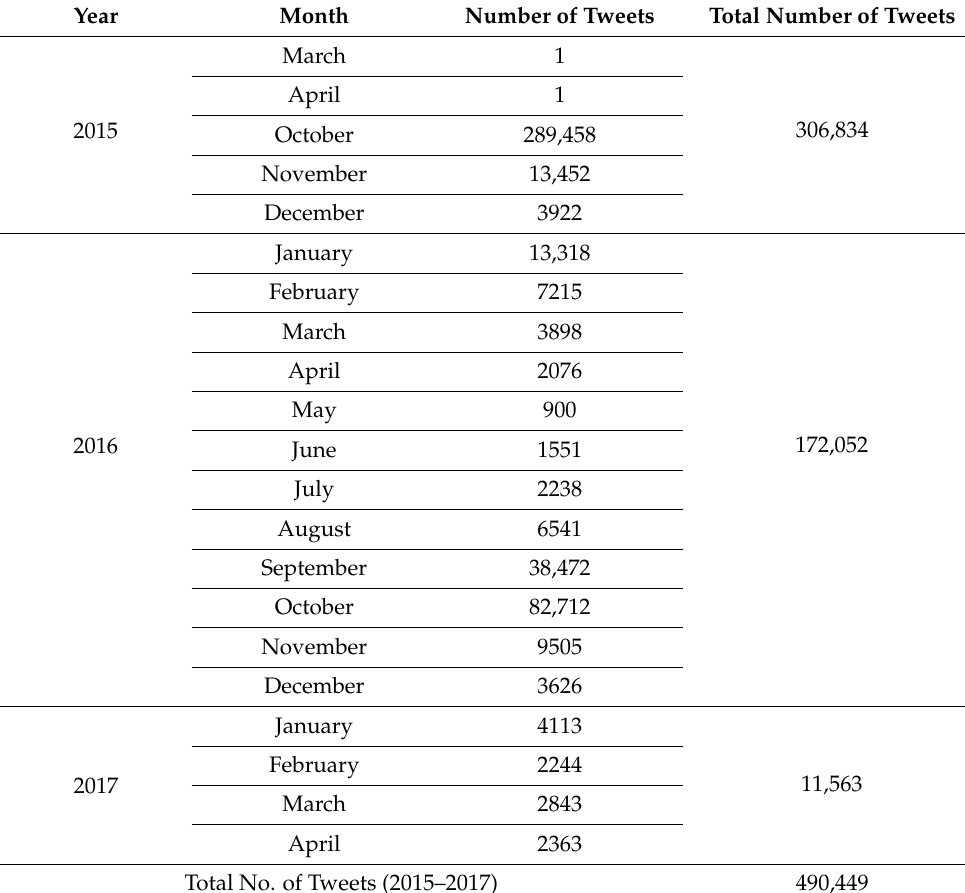
Table 3. Distribution of Tweets over the observation